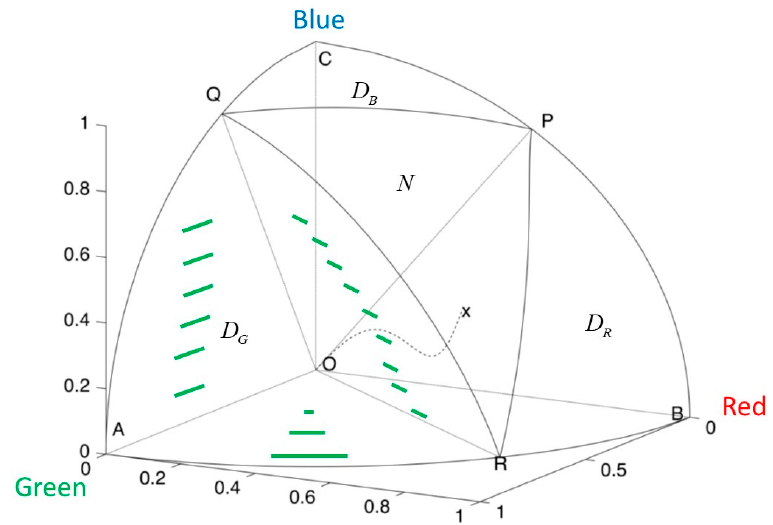
Figure 4. The case of n = 3 players where x marks initial force relative sizes and the dashed trajectory indicates the path to mutual annihilation.